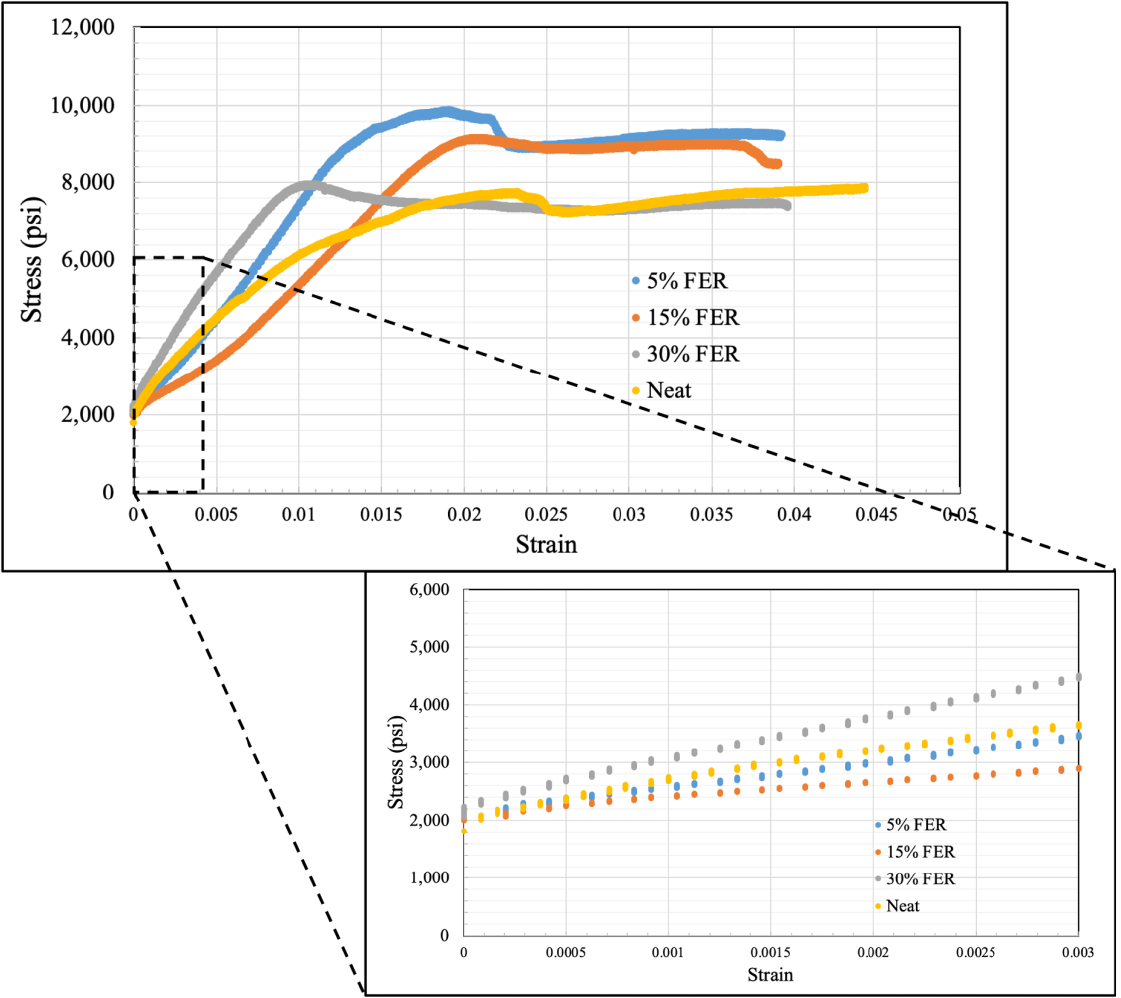
Figure 15. Triaxial test results for 5%, 15% and 30% FER-added and neat Class-H cement at 13.7 MPa confining pressure and 90 °C; 5% FER-added cement has the highest axial stress at 68.8 MPa, followed by 62.9 MPa and 54.5 MPa for the 15% and 30% additions, respectively, whereas the neat Class-H cement sample has a maximum of 53.3 MPa. These results coincide with the UCS results showing a similar trend, with 5% having the best performance. The initial linear regime is shown in a magnified scale in the inset, and the slope of this initial linear regime is used to ca lculate Young’s modulus.